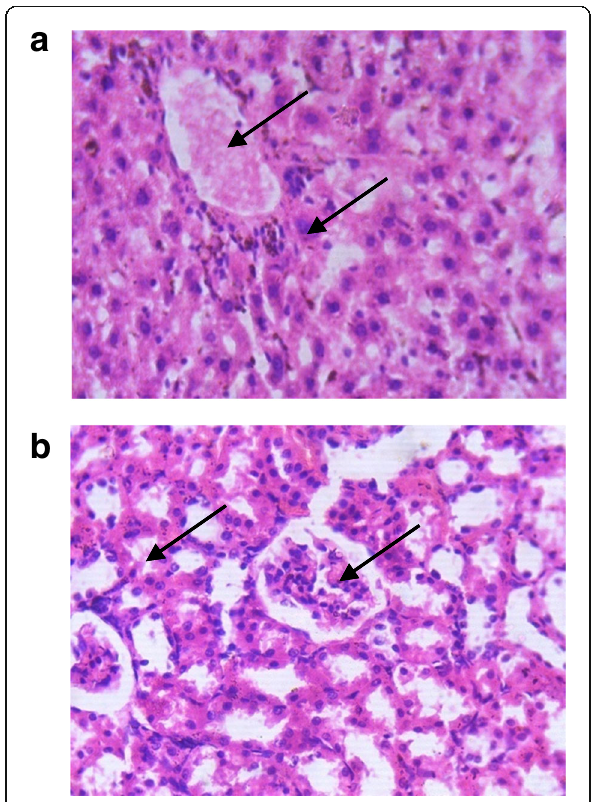
Fig. 3 a Photomicrograph of the liver section of the rats dosed with Z. mauritiana showing karyolysis and mild congestion within the central vein (× 40). b Photomicrograph of the liver section of the rats dosed with Z. mauritiana showing karyolysis and lymphocytic infiltration (× 40)